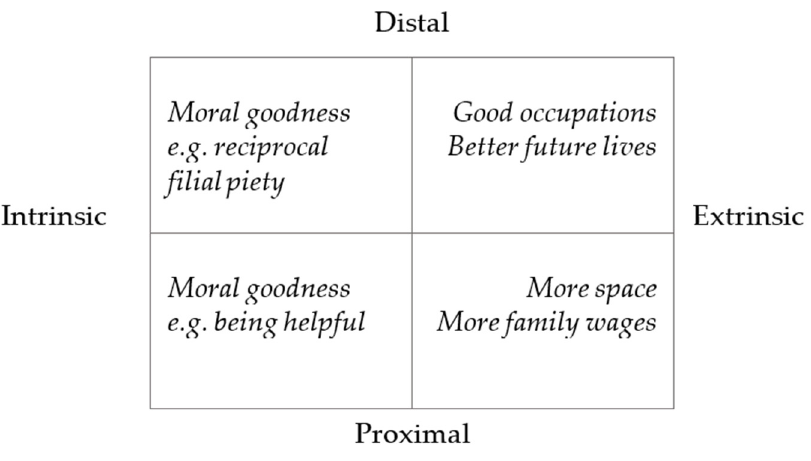
Figure 1. The complexities of children’s aspirations.